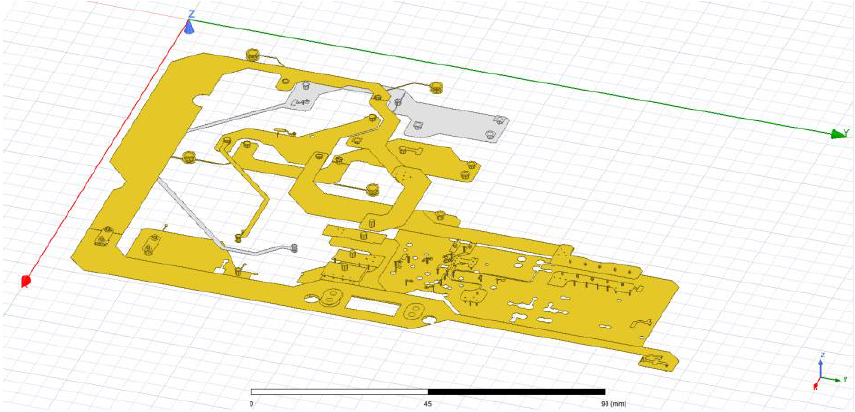
Figure 12. The Q3D layout model.